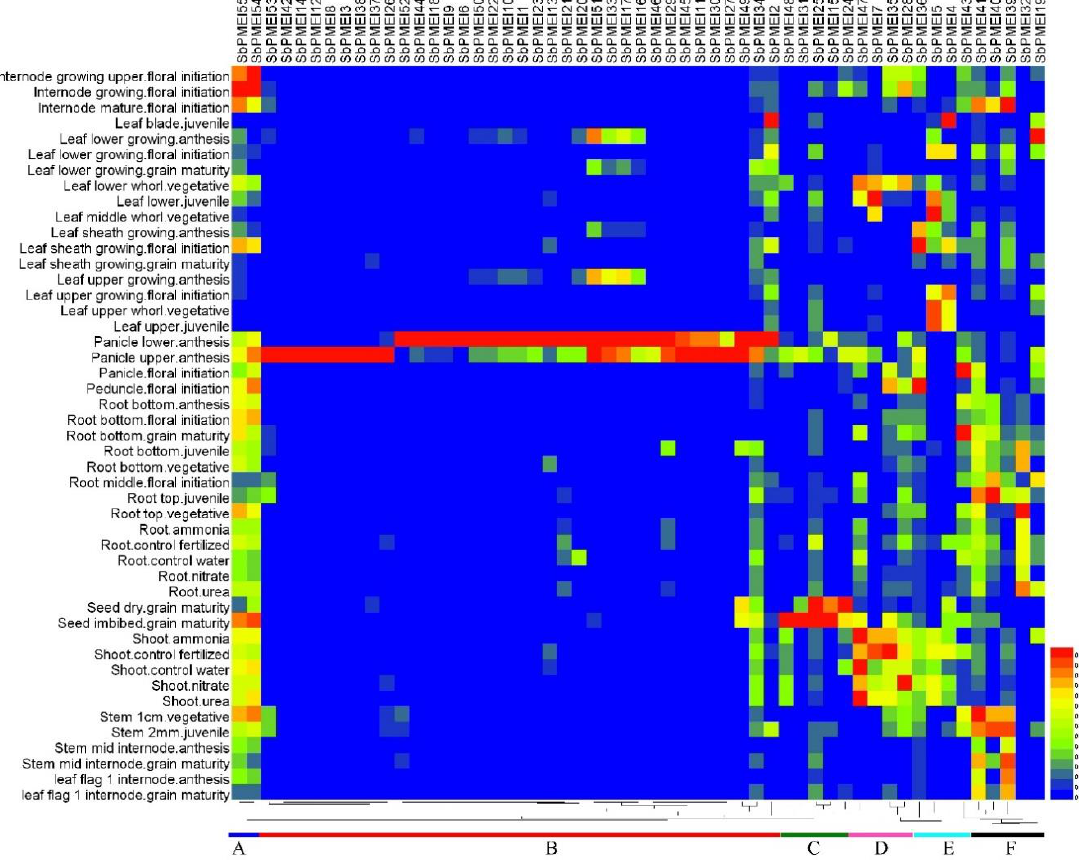
Figure 7. Heat map of 55 PMEIs in 47 tissues at different growth and developmental stages. The heat map shows the relative abundances of expressed genes. It ranges from low abundance (blue) to medium abundances (green) and high abundance (red). According to the expression patterns, six clusters ( A – F ) were classified.